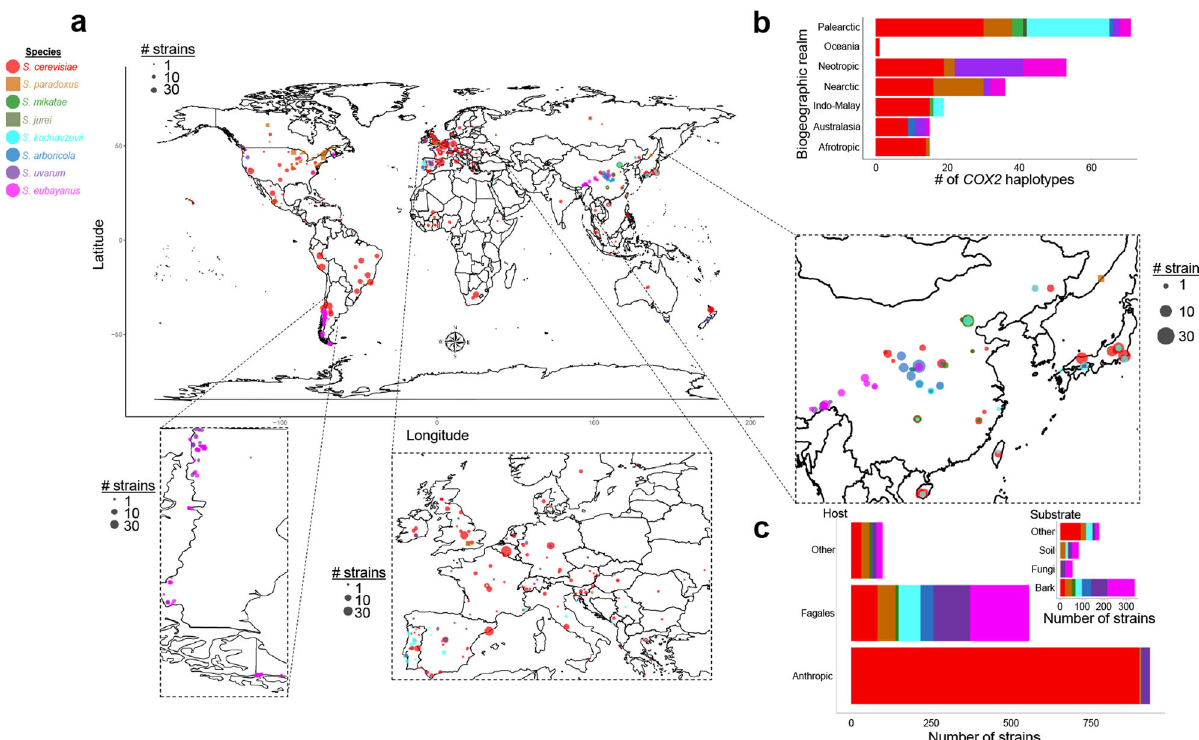
Fig. 1 | Geographic distribution of Saccharomyces strains. a Map showing the locations where wild non-interspecies hybrid Saccharomyces strains ( n =681 strains, Supplementary Data 1) have been isolated, scaled by size to the number of strains studied here. Symbols and colors designate the species. Ecolo- gicaland geographicinformationaboutthestrainscanbefoundinSupplementary Data1.Themapwasgeneratedusingthe map_data functionimplementedinthe R package ggplot2 125 . b Stacked bar plot showing the number of COX2 haplotypes ( n =138haplotypesincluding1776 COX2 sequences,SupplementaryData1)isolated ineachbiogeographicrealm(Fig.2a).Thedatashowsmany COX2 haplotypesfrom